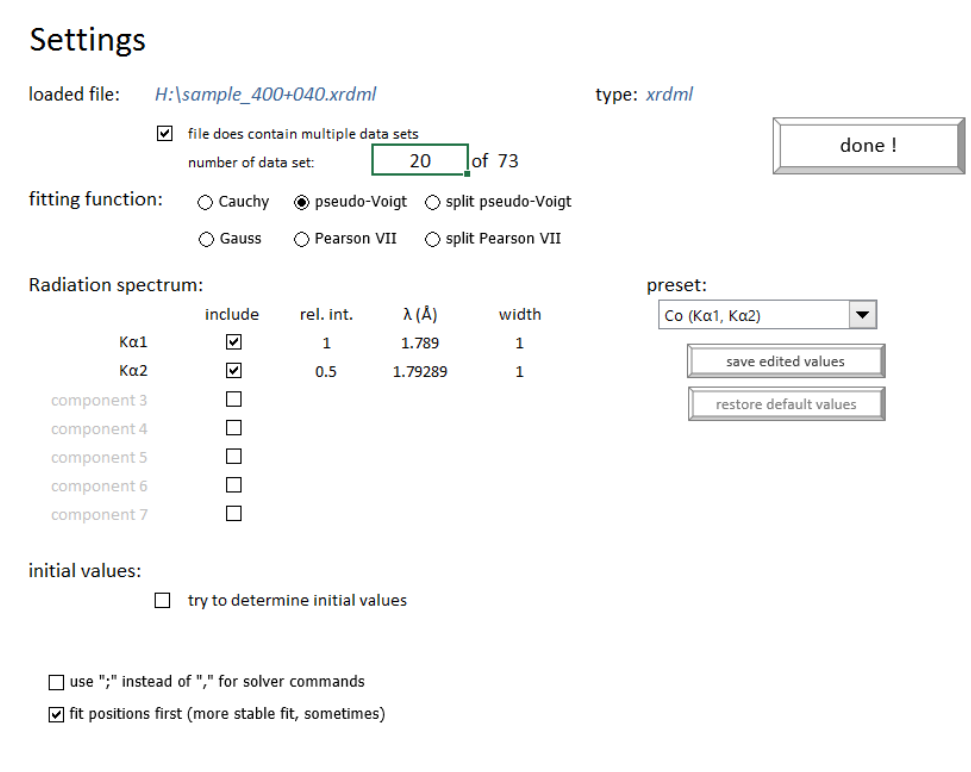
Figure 1. Program interface: Initial settings worksheet shown after the data file is chosen. Here the basic settings can be specified, such as the spectrum of the radiation, function for fitting or initialisation of the new peak parameters.